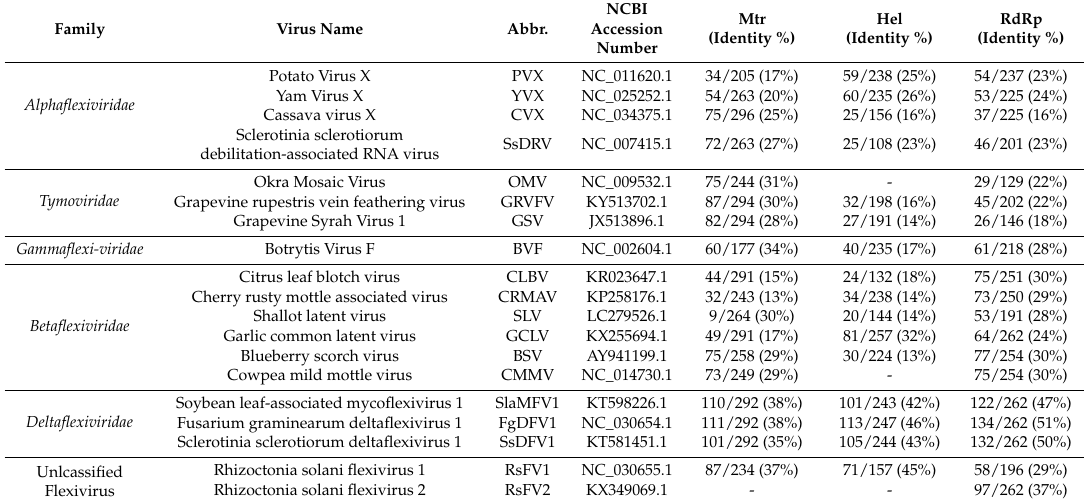
Table 2. The amino acid sequence identity between the methyltransferase, helicase, and RdRp motifs of SsDFV2 and those of selected viruses of the order